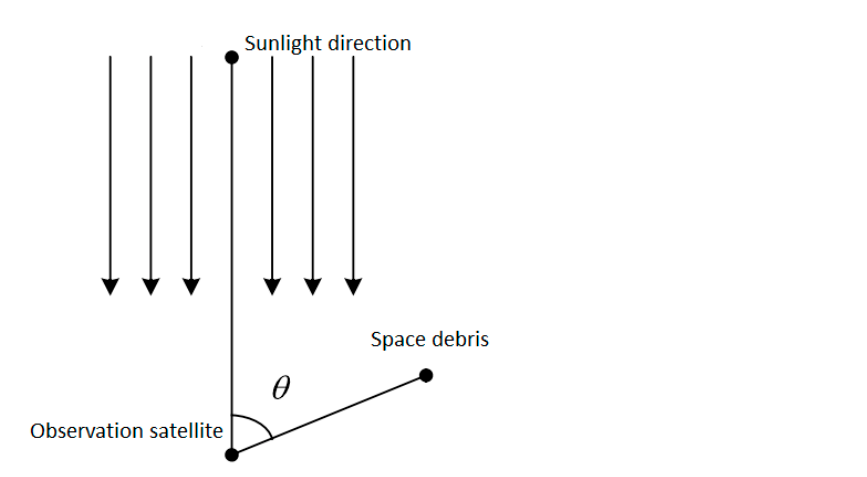
Figure 2. The relationship between satellite observations and sunlight effect. (3)